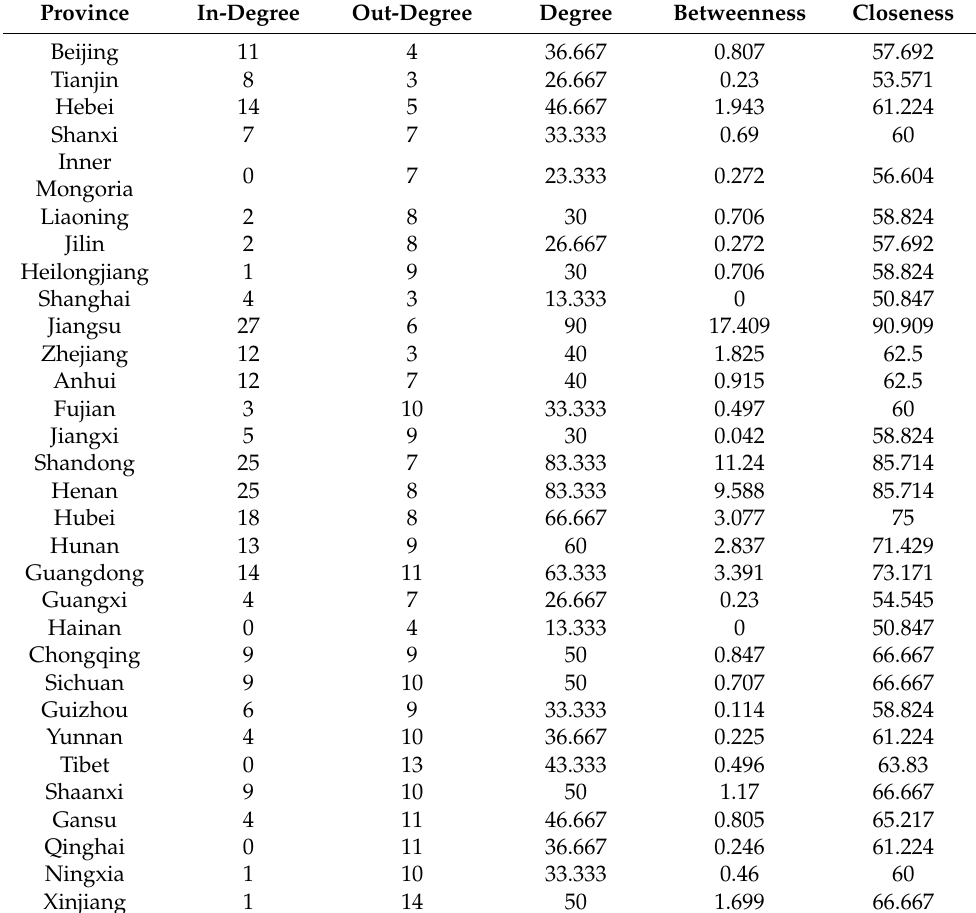
Table 1. Network centrality analysis.